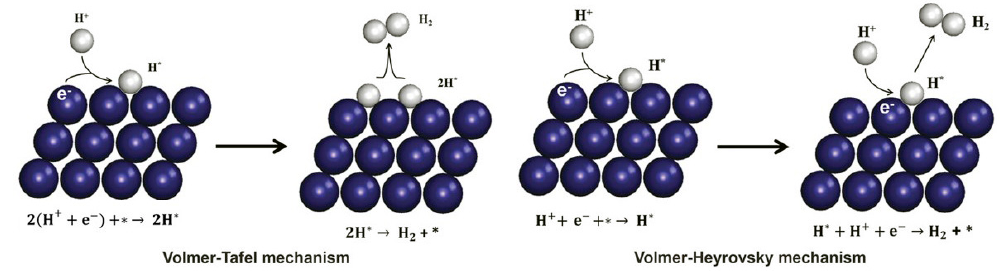
Figure 1. HER mechanisms on the catalyst surface in acidic solutions. Where the * denotes the active sites of the catalyst, H* denotes the adsorbed hydrogen atom at the active site of the catalyst. Reproduced with permission from Reference [33]. Copyright Wiley-VCH, 2019.